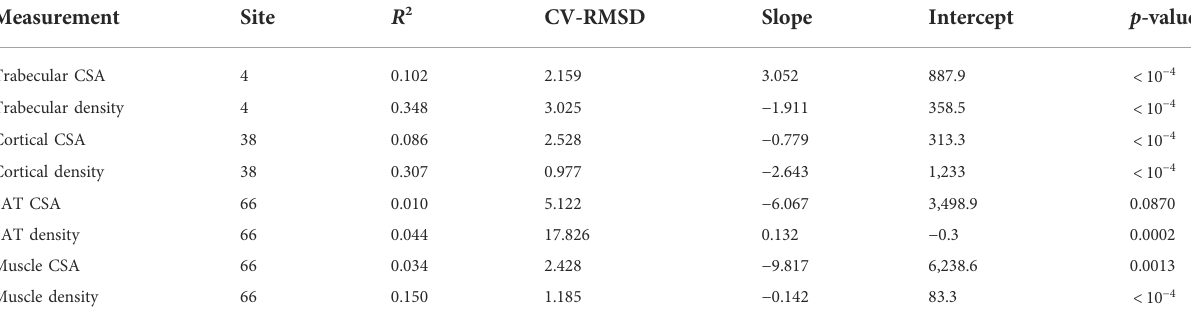
TABLE 12 Statistical measures of the relationships between tissue properties and age for females.